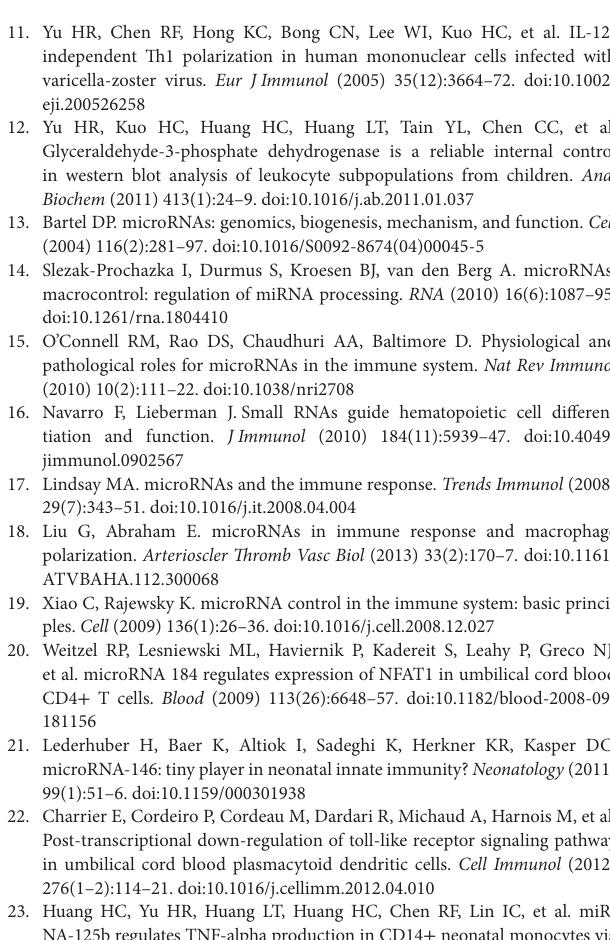
FigUre s1 | Transfection of let-7b-5p inhibitor and mimic into adult and cord blood (cB) monocytes, respectively . (a) Transfection of the let-7b-5p inhibitor into adult monocytes suppressed the expression of let-7b-5p. (B) Transfection of let-7b-5p mimic into CB monocytes enhanced the expression of